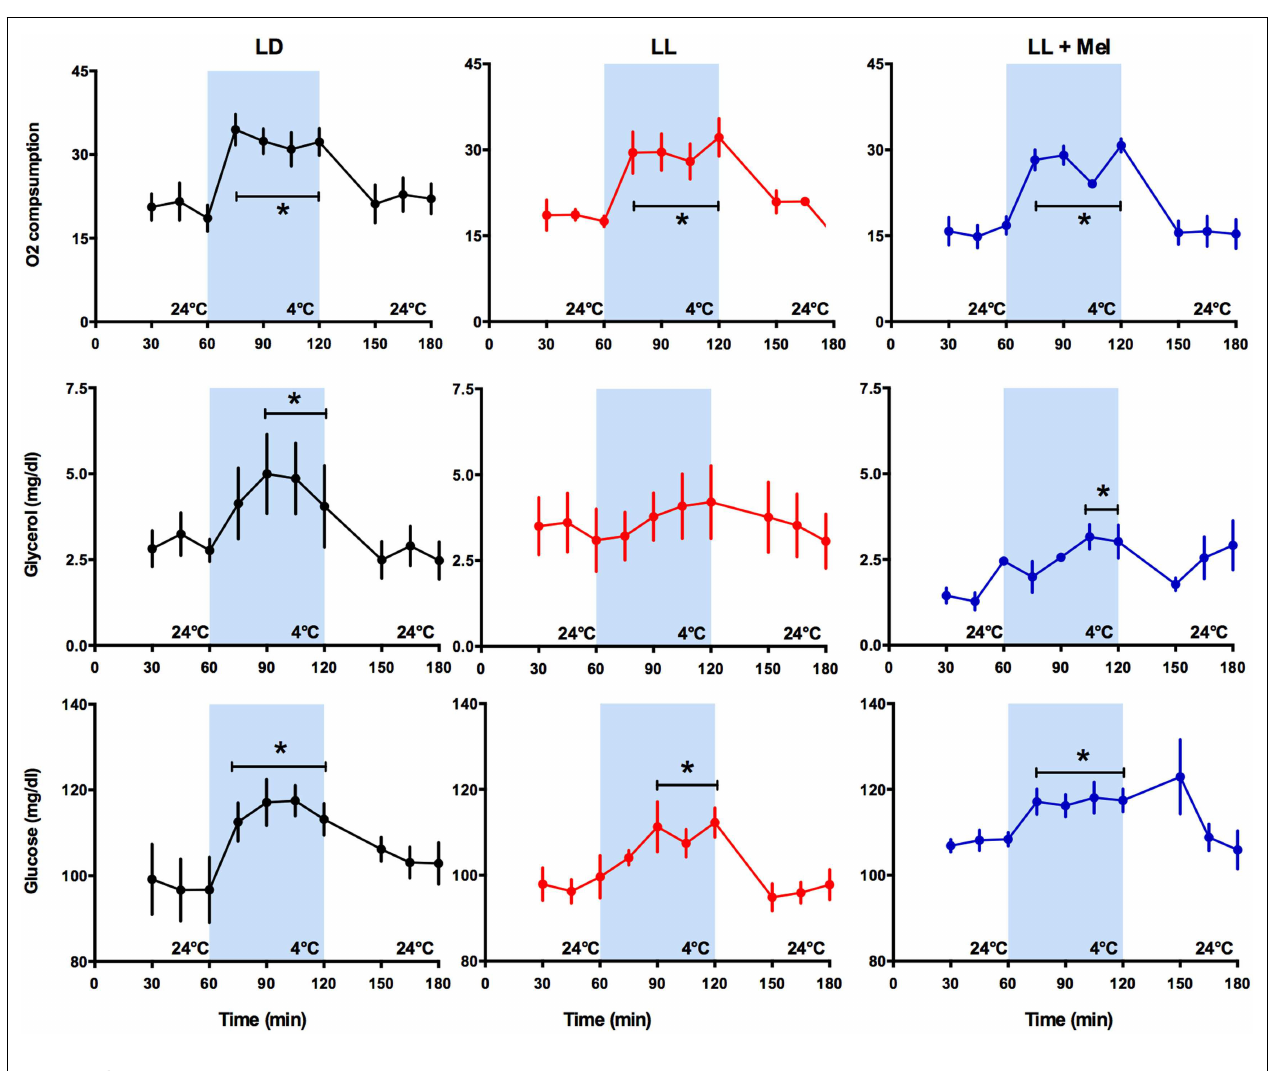
FIGURE 3 | Response of O 2 consumption and plasma glycerol and glucose to exposure to 4°C in 5days old lambs . Data are means ± SEM, LD, newborns gestated in ewes exposed photoperiod 12:12; LL, newborns gestated in ewes kept in continuous light from